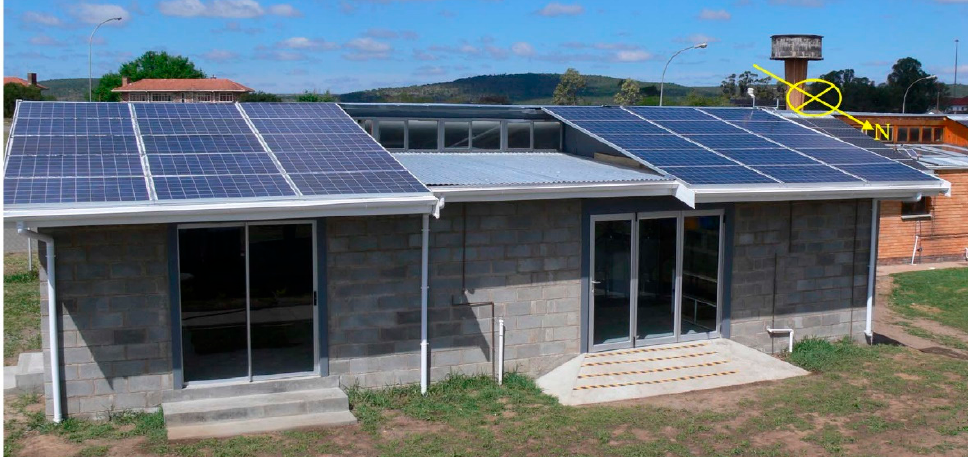
Figure 1. Passive solar building in SolarWatt Park at the University of Fort Hare in